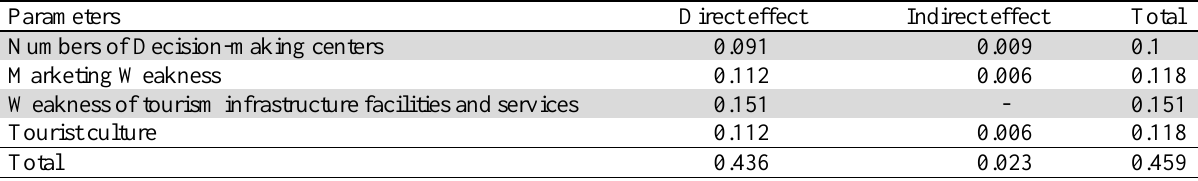
The summary of the effects of direct and indirect